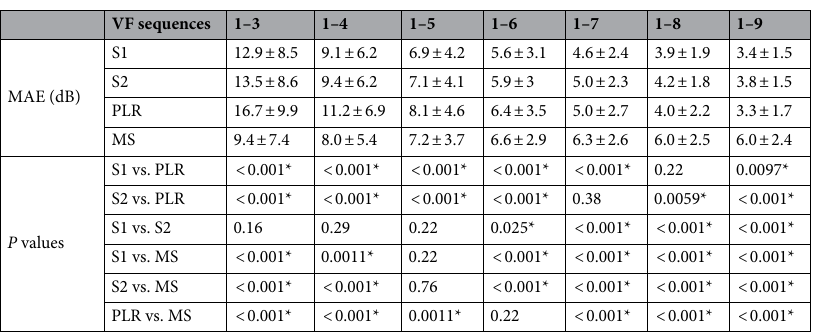
Table 3. Mean absolute error when predicting the 10th VF. * P < 0.05. VF visual field, MAE mean absolute error, PLR pointwise linear regression, MS mean